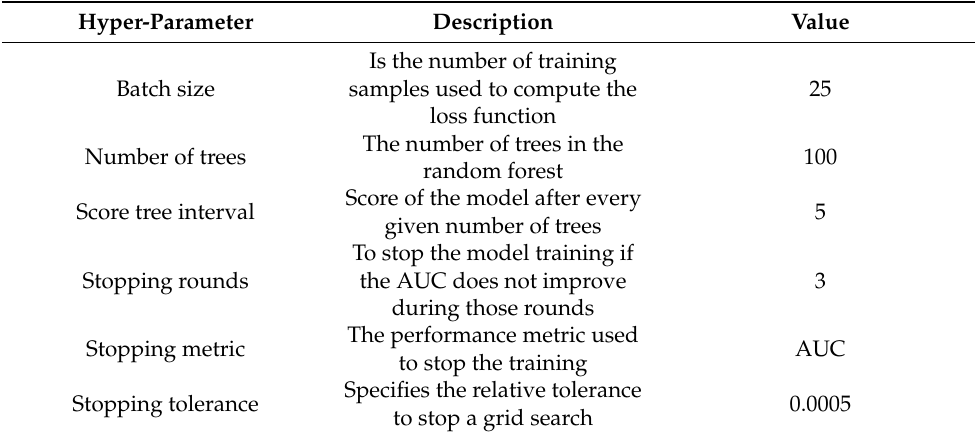
Table 3. Optimized DRF